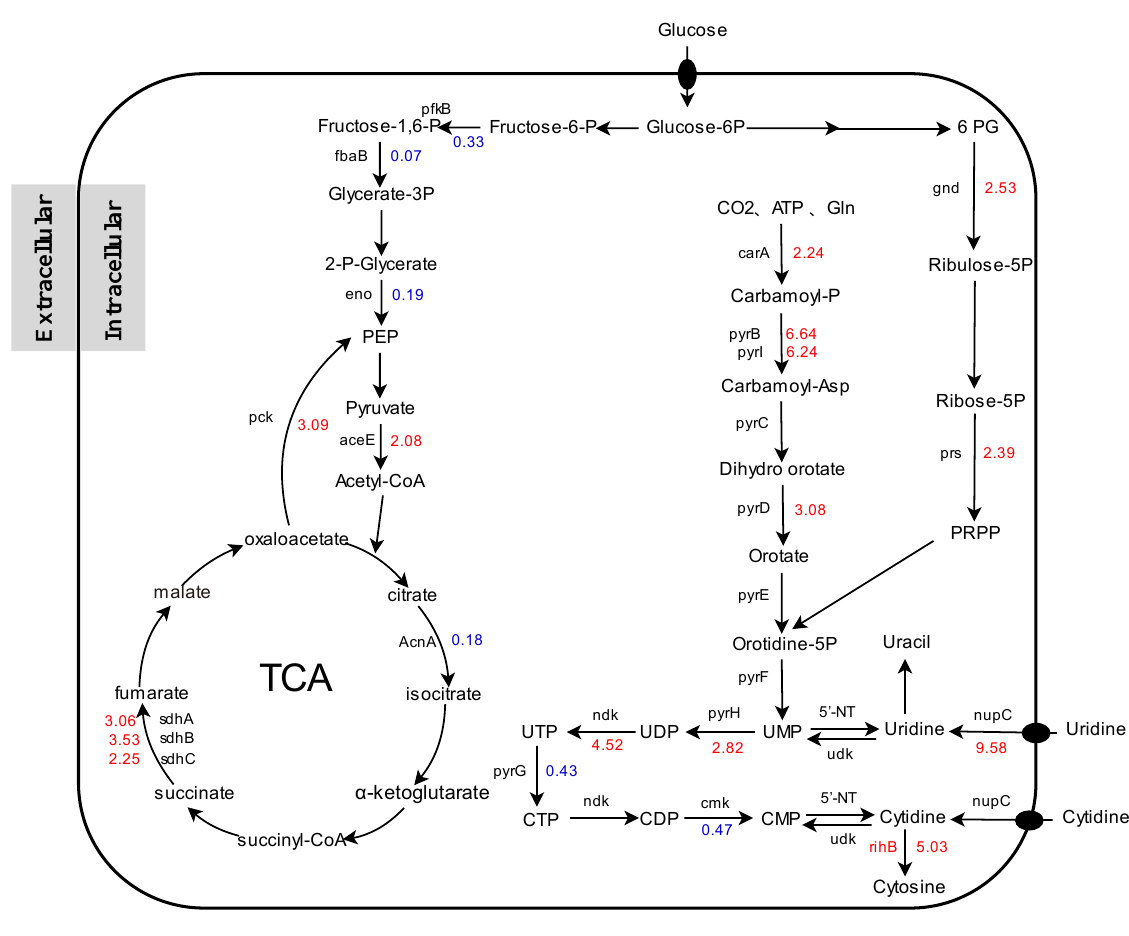
Figure 6. Schematic diagram of gene expression involved in cytidine synthesis-related pathways. Numbers represent the difference multiple of a gene between E. coli NXBG-11 and E. coli NXBG-12, blue representing downward adjustment and red representing upward adjustment.